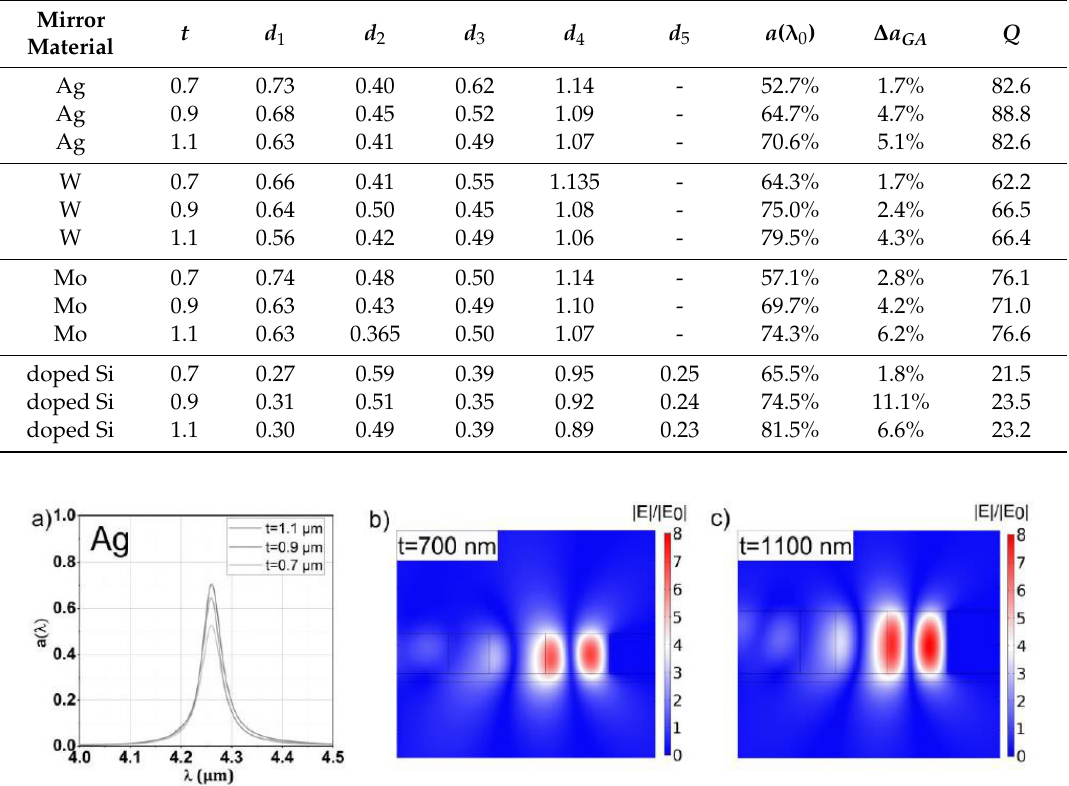
Table 2. Layer thicknesses, plasmon-enhanced absorptance, relative improvements of the GA optimization process and Q factors obtained for the optimized configurations.